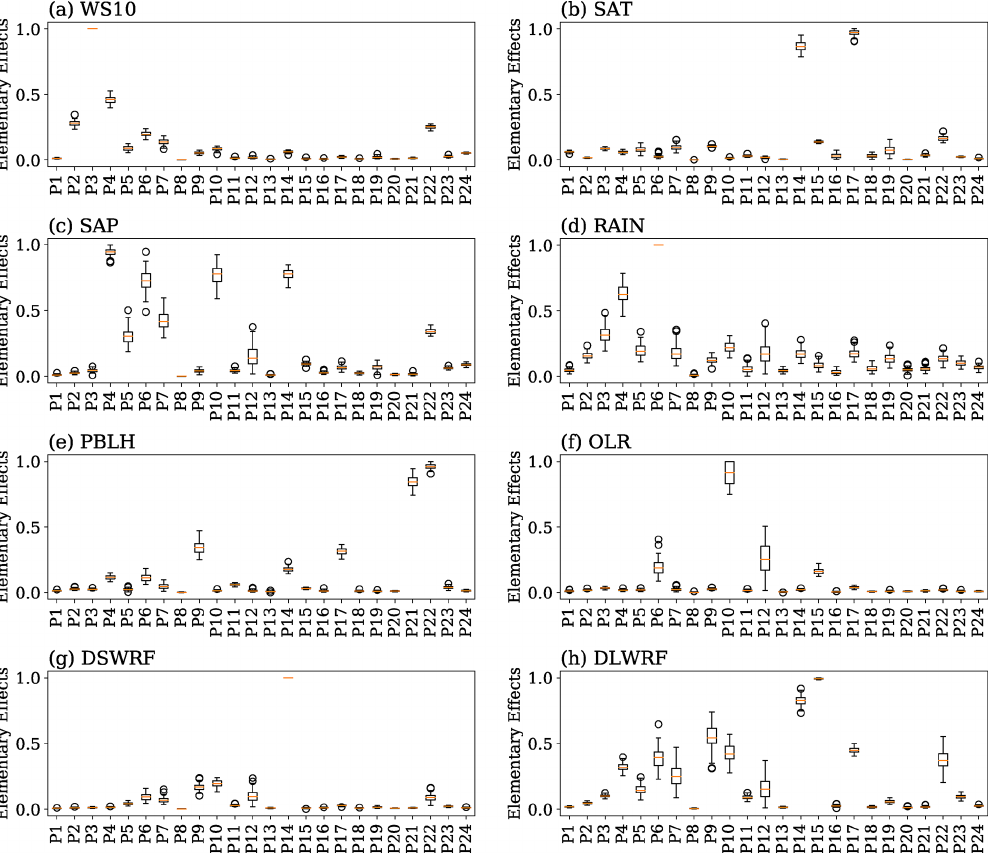
Figure 4. Boxplot of the elementary effects of 24 parameters for the meteorological variables considered. Each dataset is created with 100 applications of bootstrap resampling out of 10 instances. The center lines (red) are the median values; the top and bottom of the boxes are the average ± 1 standard deviation; the upper and lower whiskers are the maximum and minimum